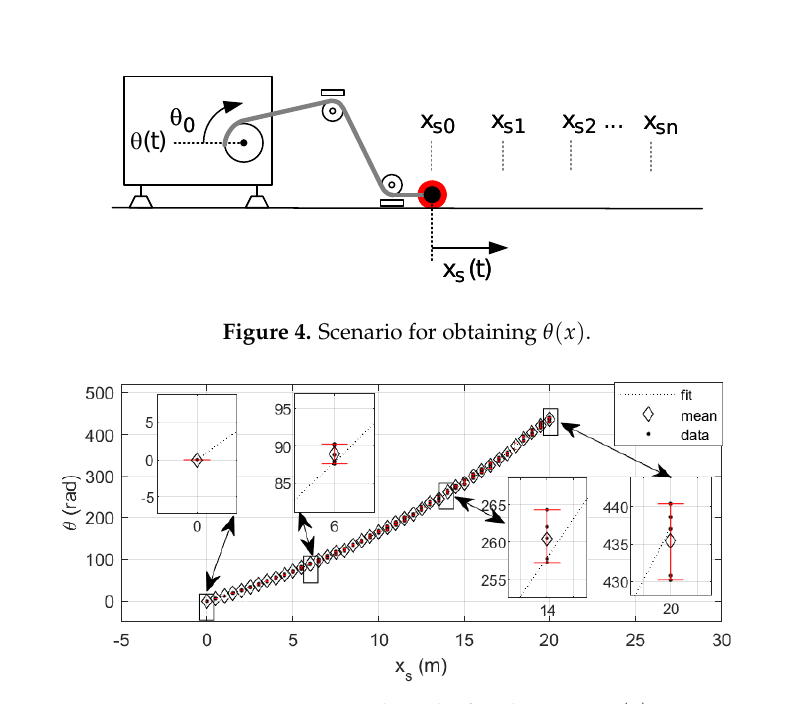
Figure 5. Experimental results for obtaining x s ( θ ) .